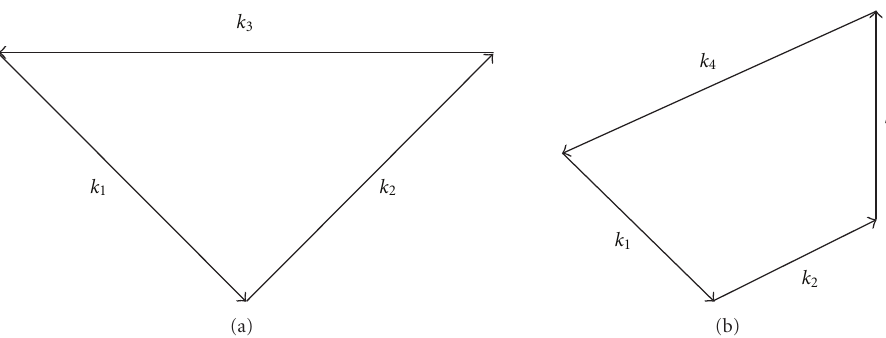
Figure 7: Representation of momentum conservation for the bispectrum (the three momenta form a closed triangle) and for the trispectrum (the momenta form a